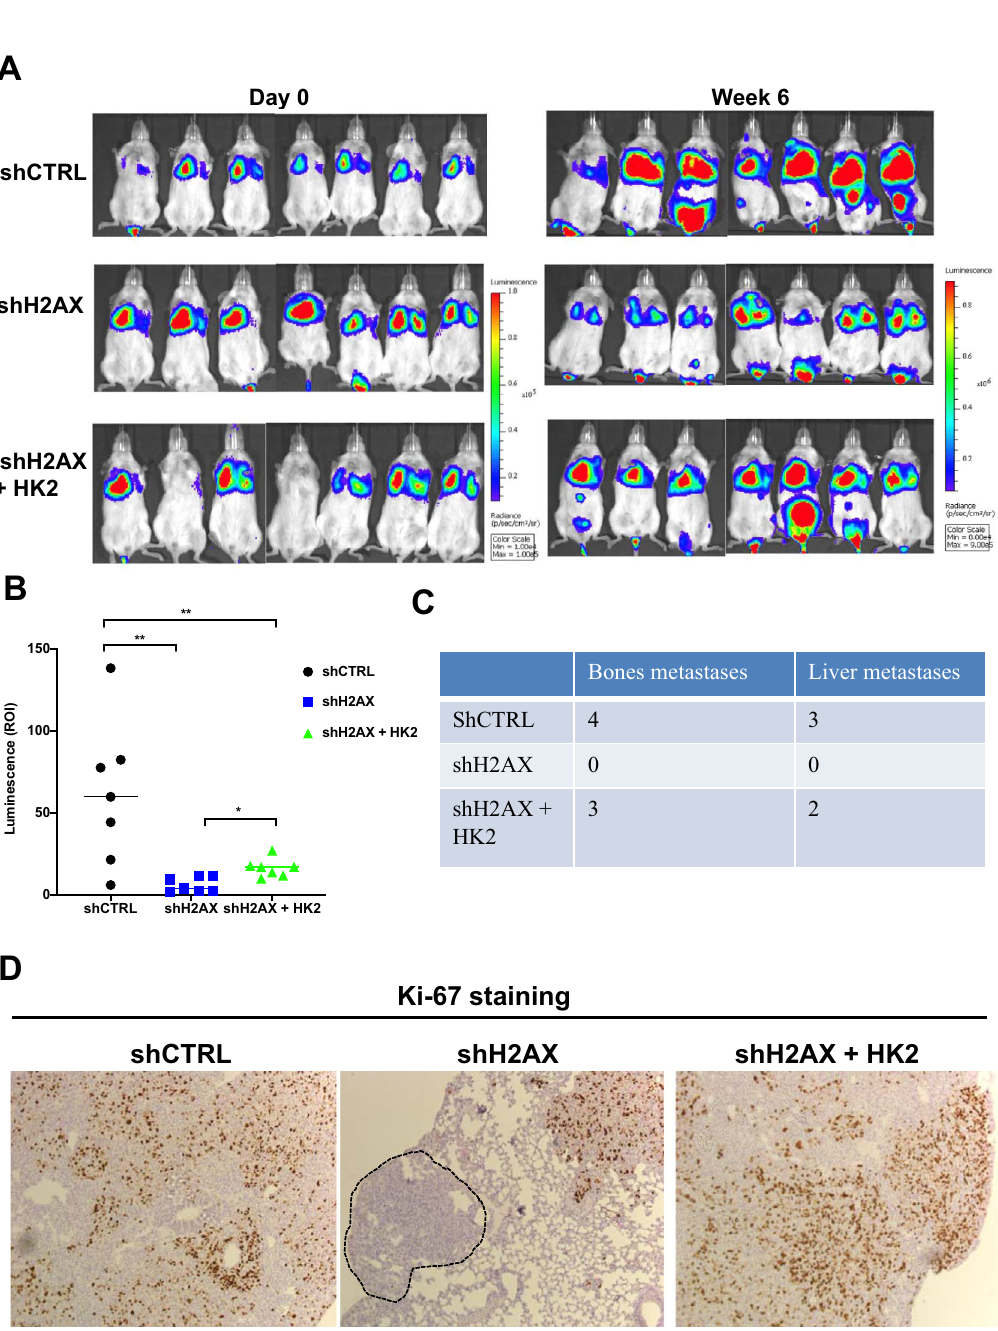
Figure 4. HK2 re-expression in H2AX-deficient cells partly restores metastatic colonization in the lung. ( A ) MDA-MB-231 control cells with empty vector (shCTRL), H2AX-deficient cells with empty vector (shH2AX), and H2AX-deficient in which HK2 was reintroduced (shH2AX + HK2) were inoculated via the tail veins of immunocompromised NOD SCID gamma mice, and animals were used for bioluminescence-based imaging from one week up to six weeks. The extent to which tumor cells exhibit growth and metastatic progression was monitored. Control cells (shCTRL) showed significantly elevated tumor growth in the lung as well as distant metastases to bones and liver, while H2AX-deficient cells showed a 60% reduction in tumor growth with no detectable distant metastases. Ectopic expression of HK2 resulted in a partial restoration of growth and metastastic potential. ( B ) Quantification of the luminescence detected in the lung. ( C ) The extent to which tumor cells metastasize outside the lung was analyzed by monitoring the presence of bioluminescence in the body. Note that luminescence was primarily detected in bones and liver specifically when animal were injected with either control cells (shCTRL) or with H2AX-deficient cells ectopically expessing HK2 (shH2AX + HK2). ( D ) Representative Ki-67-stained lung sections from mice injected with control cells with empty vector (shCTRL), H2AX-deficient cells with empty vector (shH2AX) and H2AX-deficient cells in which HK2 was reexpressed (shH2AX + HK2). Dashed lines indicate tumor regions in mice bearing H2AX- deficient cells with negative Ki-67 staining, implying presence of less aggressive tumor cells. Statistical significance was determined by a two-tailed, unpaired Student’s t -test. Error bars represent S.E.M. ( n = 7 per group). *pvalue < 0.05; **p value ≤